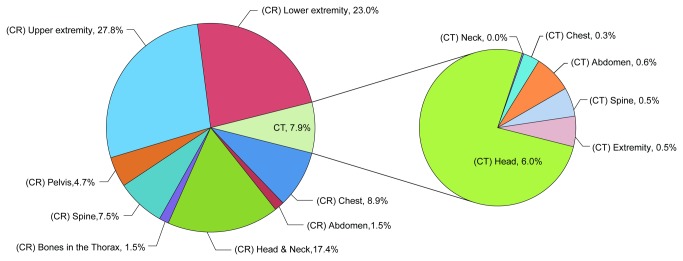
Proportion of radiological examinations (n = 78,025).CR: conventional radiography; CT: computed tomography.